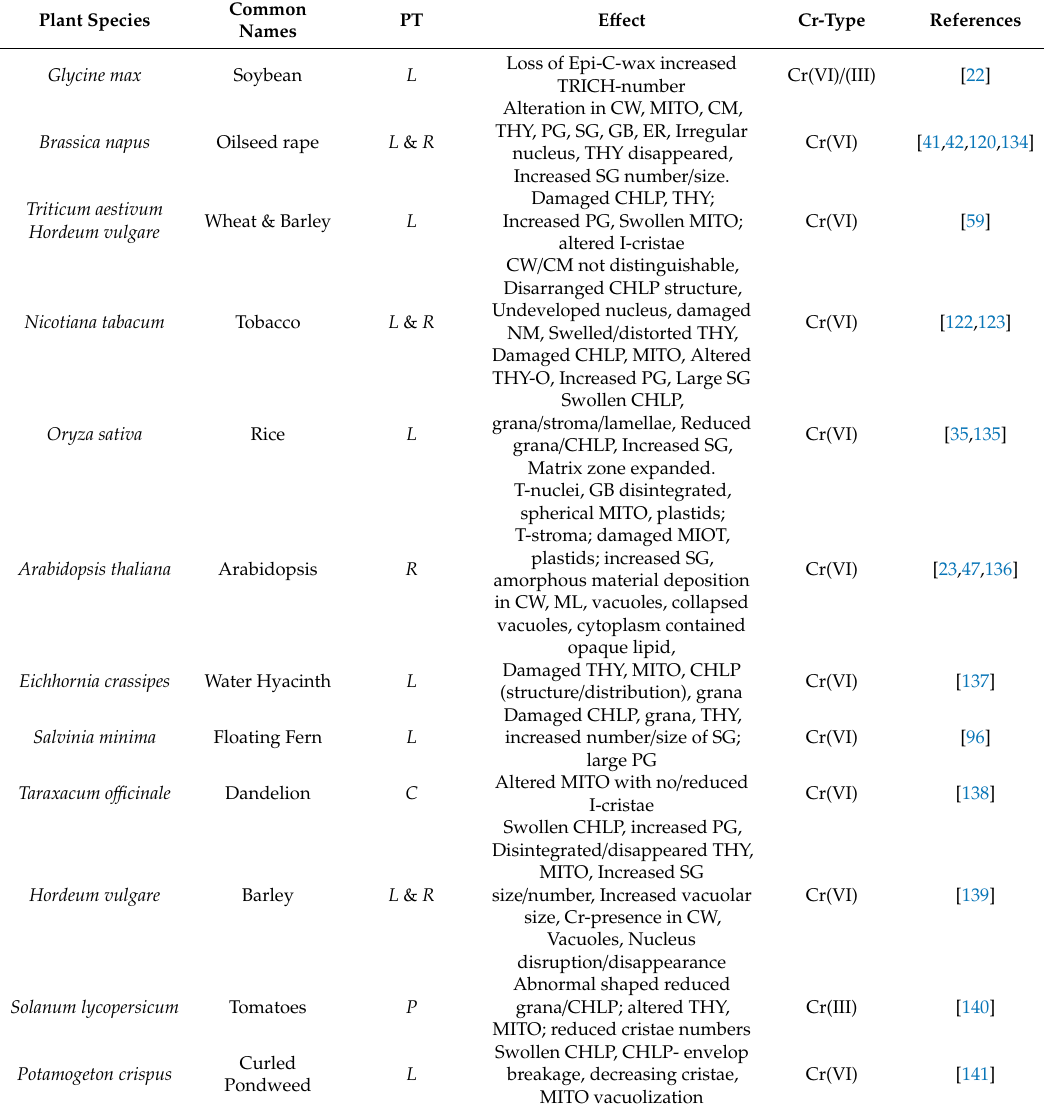
Table 5. Chromium-induced ultra-structure variation in numerous plant species. Epi-C-wax (epicuticular wax), TRICH (trichome), CW (cell wall), MITO (mitochondria), CM (cell membrane), THY (thylakoid), THY-O (thylakoid orientation), PG (plastoglobuli), SG (starch grains), GB (Golgi bodies), ER (endoplasmic reticulum), CHLP (chloroplast), I-cristae (interior- Cristae), T-nuclei (tubular nuclei), T-stroma (translucent stroma), ML (middle lamella), NM (nuclear membrane), and PT (Plant tissue